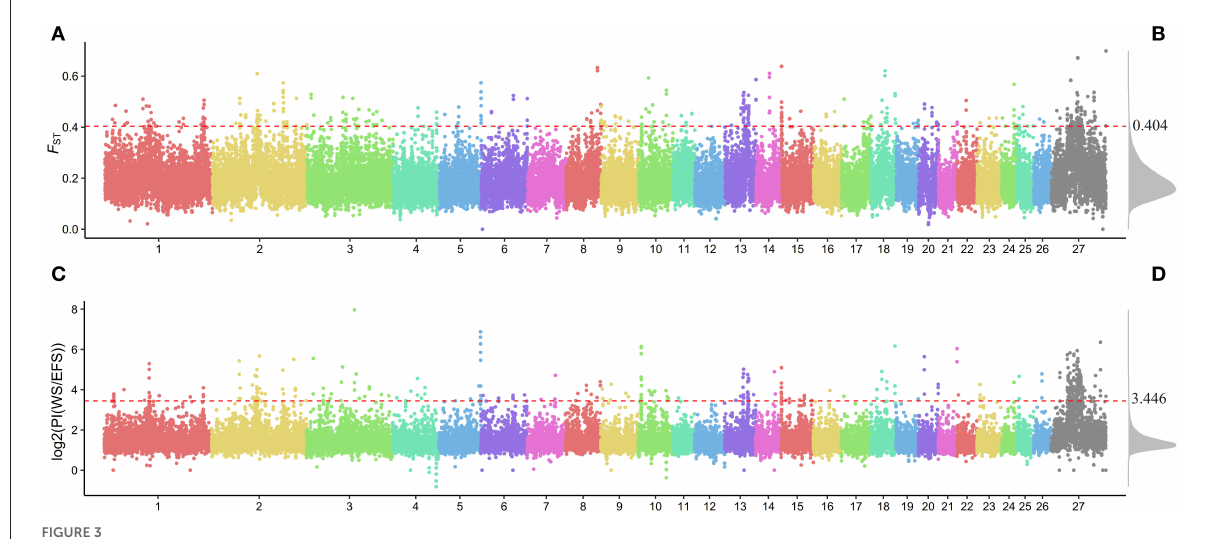
FIGURE3 Genome-wide distribution of F ST and θ π ratio. (A) Genome-wide distribution of F ST . (B) Genome-wide density distribution of F ST . (C) Genome-wide distribution of PI [log2(PI(WS/EFS))]. (D) Genome-wide density distribution of PI. The horizontal red dashed line in the figure shows the window for the top 1% of F ST and PI.